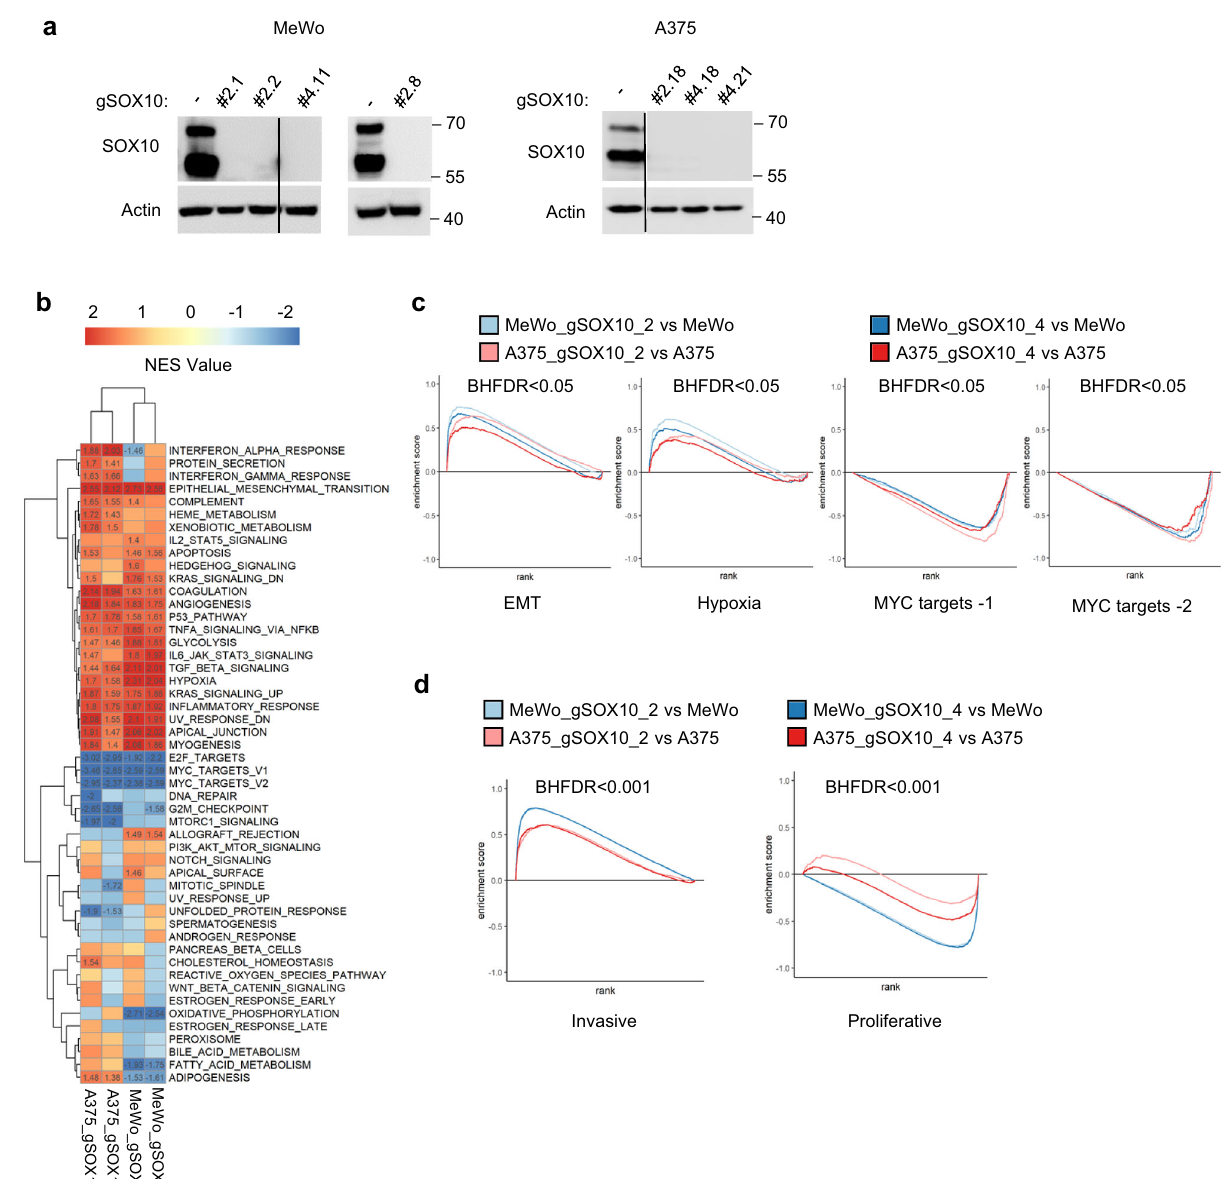
Fig. 2 SOX10 regulates the transcription of genes involved in invasion, proliferation, and cell metabolism pathways. a MeWo and A375 SOX10 knockout cell lines were generated as described in Materials and Methods. The same number of parental and SOX10 knockout cells were seeded in six-well plates for each cell line. Cells were lysed and lysates western blotted as indicated. The experiment was repeated independently three times with similar results. b A heatmap showing GSEA normalized enrichment scores (NES) for the hallmark gene sets collection for MeWo and A375 SOX10 knockout cells (guide #2 and #4) compared to parental cells. NES values are displayed for enriched gene sets, using a Benjamini-Hochberg False Discovery Rate (BHFDR) cutoff of 0.05. MeWo gRNA#2 includes combined data collected from clones # 2.1, # 2.2, and # 2.8. For all other samples (MeWo gRNA #4, and A375 gRNA#2 and gRNA#4), shown is the mean from three independent replicates generated for each clone. c Enrichment plots of EMT, Hypoxia, MYC targets- 1 and MYC targets-2 comparing MeWo and A375 SOX10 knockout cells (guide #2 and #4) with parental cells. d Enrichment plots of proliferative and invasive gene signature (Verfaille, et al.) for MeWo and A375 CRISPR SOX10 knockout (guide #2 and #4) vs parental cells. BHFDR < additionally co-mixed the four MeWo SOX10 knockout clones at equal ratios to generate a SOX10 knockout pool. Consistently, we observed similar changes in invasive and proliferative markers in the MeWo SOX10 knockout pool and A375 SOX10 knockout cells when compared to MeWo and A375 parental cells, respec- tively (Supplementary Fig. 2A, B).